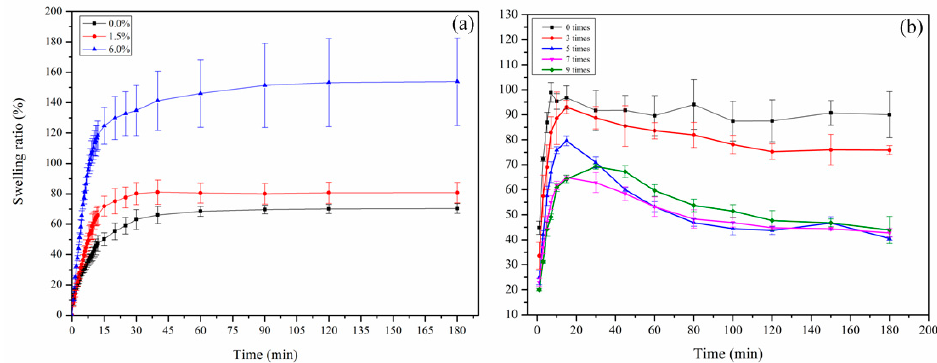
Figure 9. The swelling ratios of ( a ) the CDs/HA/PVA DN hydrogels with mass ratios of CDs to PVA at 0%, 1.5%, and 6.0% and ( b ) CDs 3.0 /HA 0.6 /PVA DN hydrogels with 0, 3, 5, 7, and 9freezing/thawing cycles, respectively.